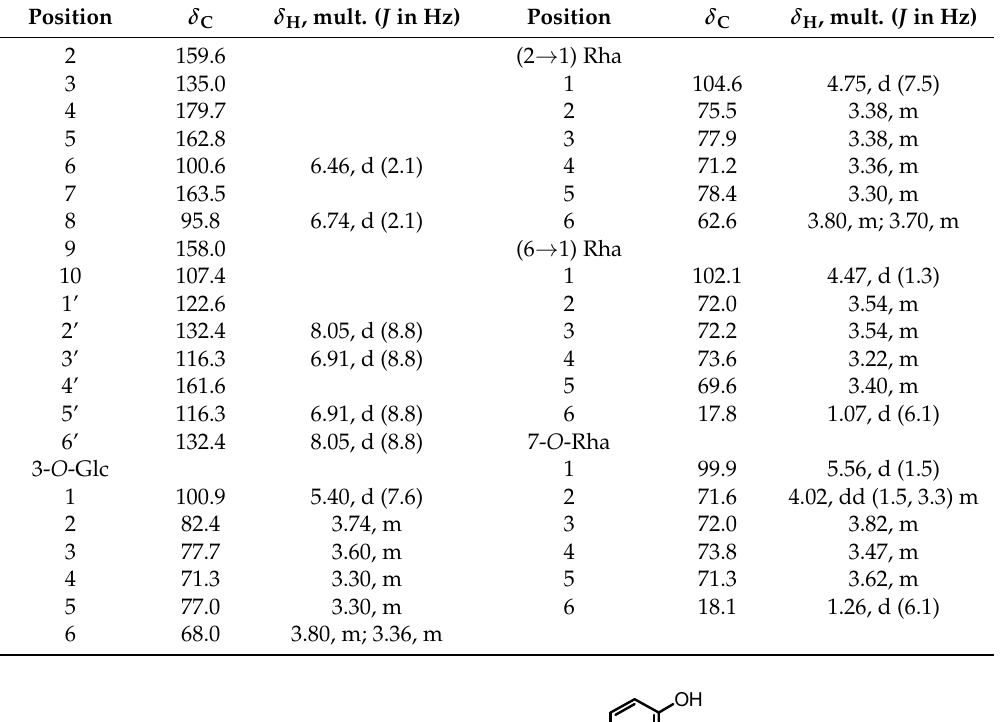
Table 1. 1 H and 13 C-NMR data of compound 1 .